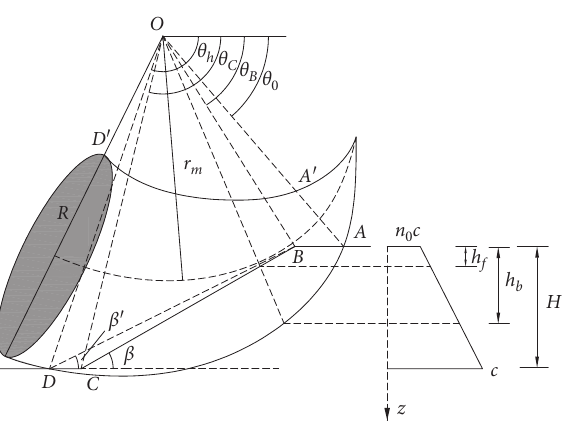
Figure 3: Nonhomogeneous